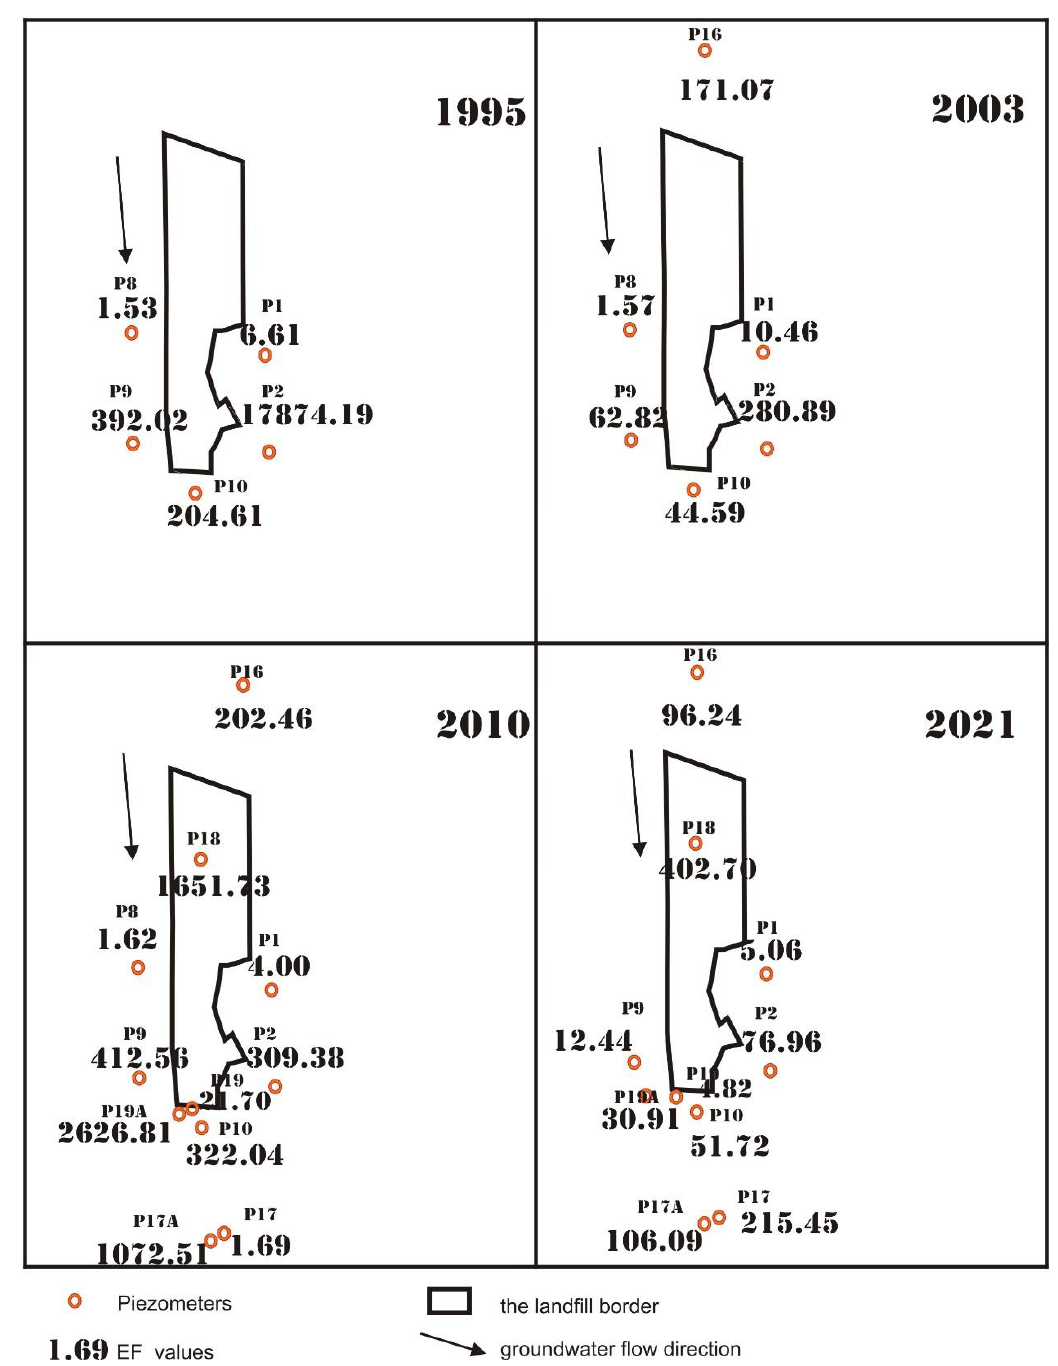
Figure 6. EF values in 1995, 2003, 2010, and 2021.